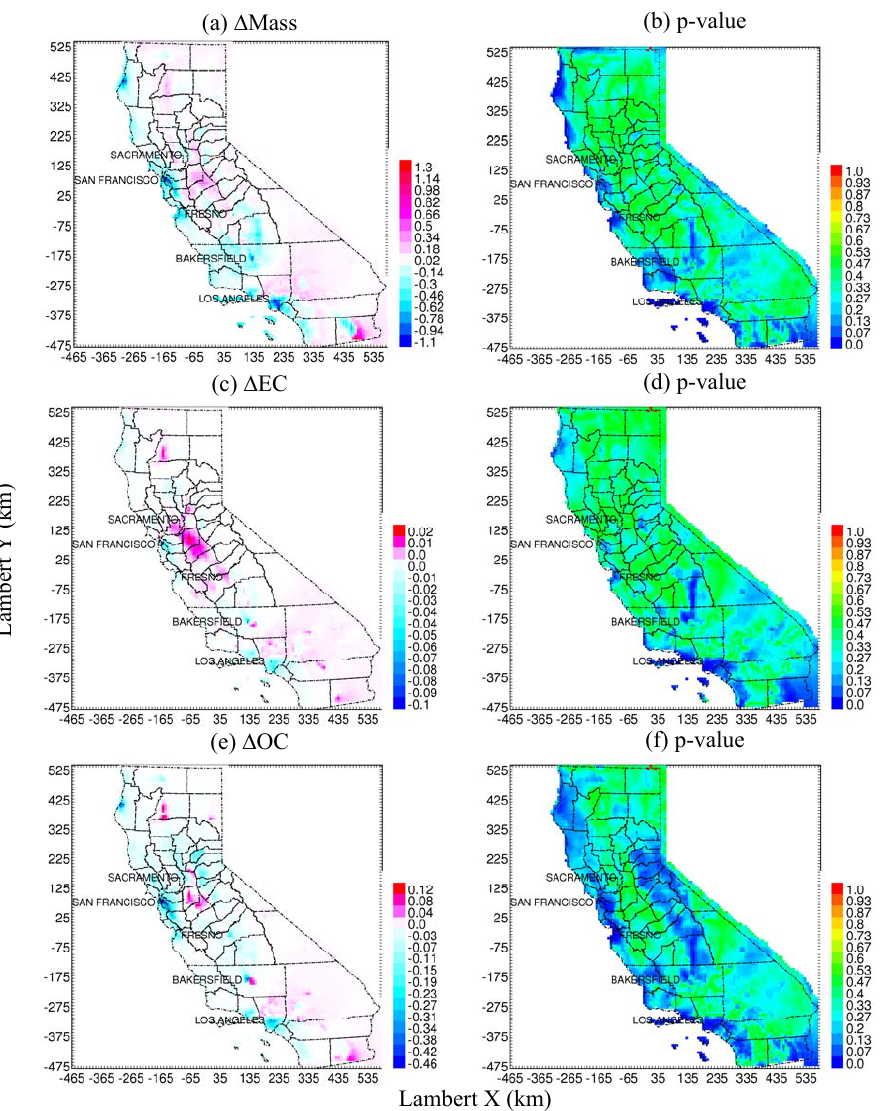
Fig. 6: Changes in annual average total mass and primary PM 2.5 concentrations, and their corresponding p-values in CA likely to occur in the future (2047-53) due to climate Fig. 6. Changes in annual average total mass and primary PM 2 . 5 concentrations, and their corresponding p-values in CA likely to occur in change from the present-day (2000-06). The p-value quantifies the likelihood that the future (2047–2053) due to climate change from the present-day (2000–2006). The p-value quantifies the likelihood that average future average future concentrations are equal to present day concentrations. concentrations are equal to present day